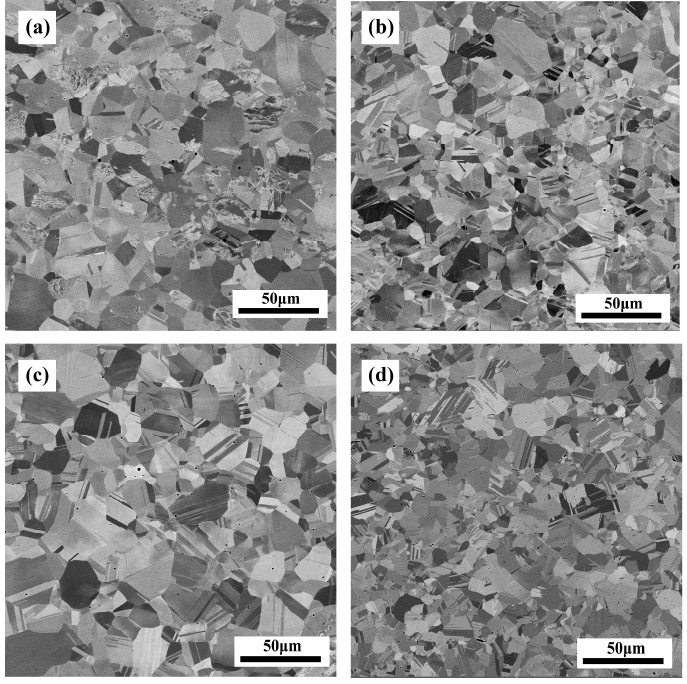
Figure 3. SEM image of base material before welding. ( a ) 304ss; ( b ) CoCrFeNi; ( c ) CoCrNi; ( d ) CoNiV.